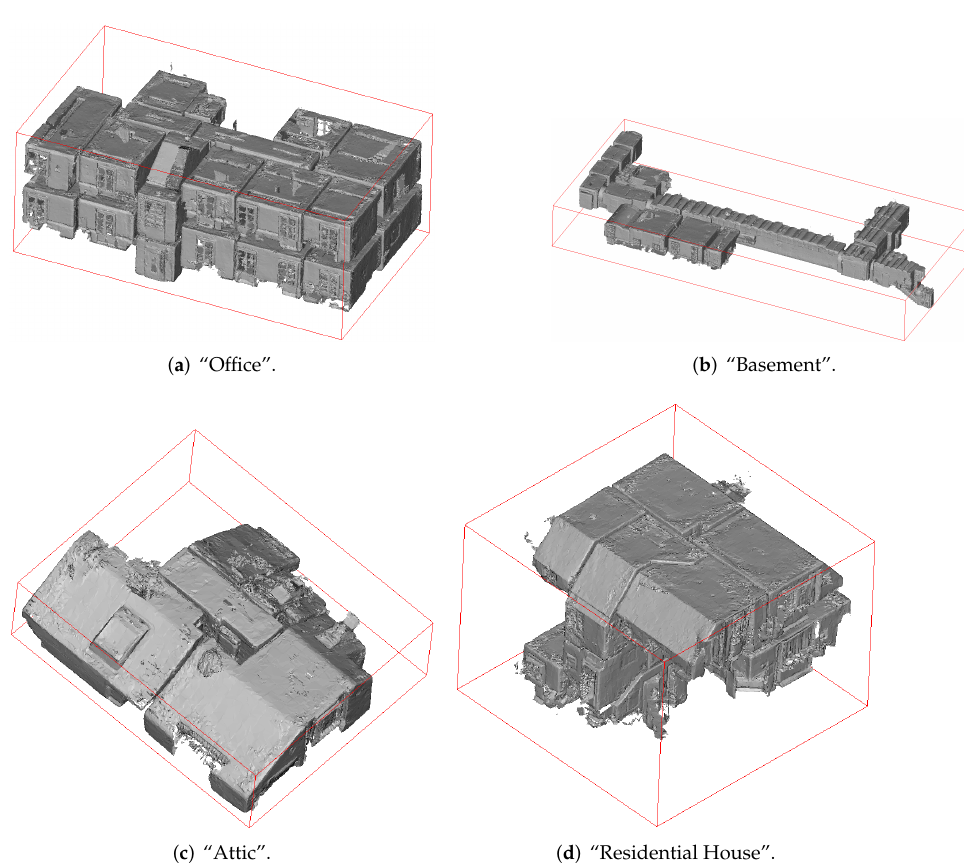
Figure 12. The Microsoft HoloLens triangle meshes published in [31] and used for evaluation in this paper. The red box indicates the aligned ground truth